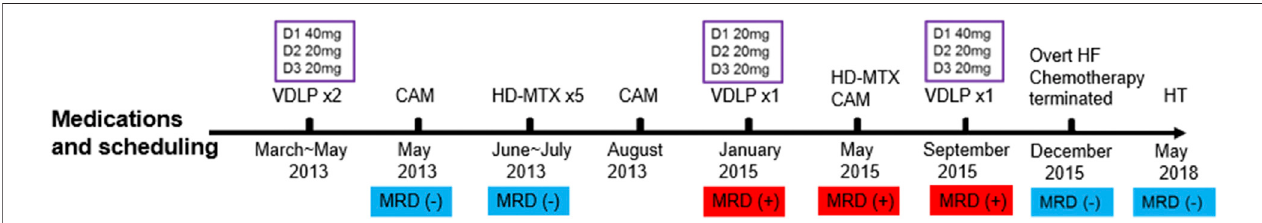
FIGURE 1 | The detailed information of chemotherapy and MRD; VDLP: vindesine (VDS), daunorubicin (DNR), L -asparaginase, and prednisone; CAM: cyclophosphamide (CTX), cytarabine (Ara-C), and mercaptopurine (6-MP). HD-MTX: high dose of methotrexate; HF: heart failure; HT: heart transplantation. The purple